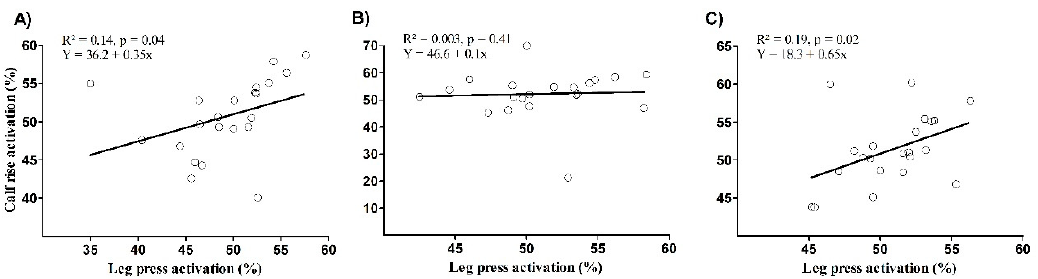
Figure 3. Correlation between calf raise and leg press mean EMG for the lateralis gastrocnemius ( A ), the medialis gastrocnemius ( B ), and the soleus ( C ).